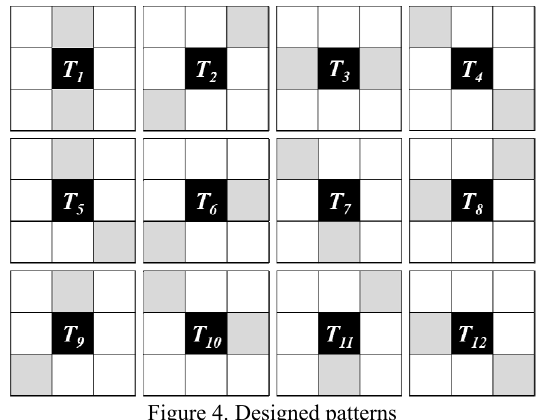
Figure 4. Designed patterns